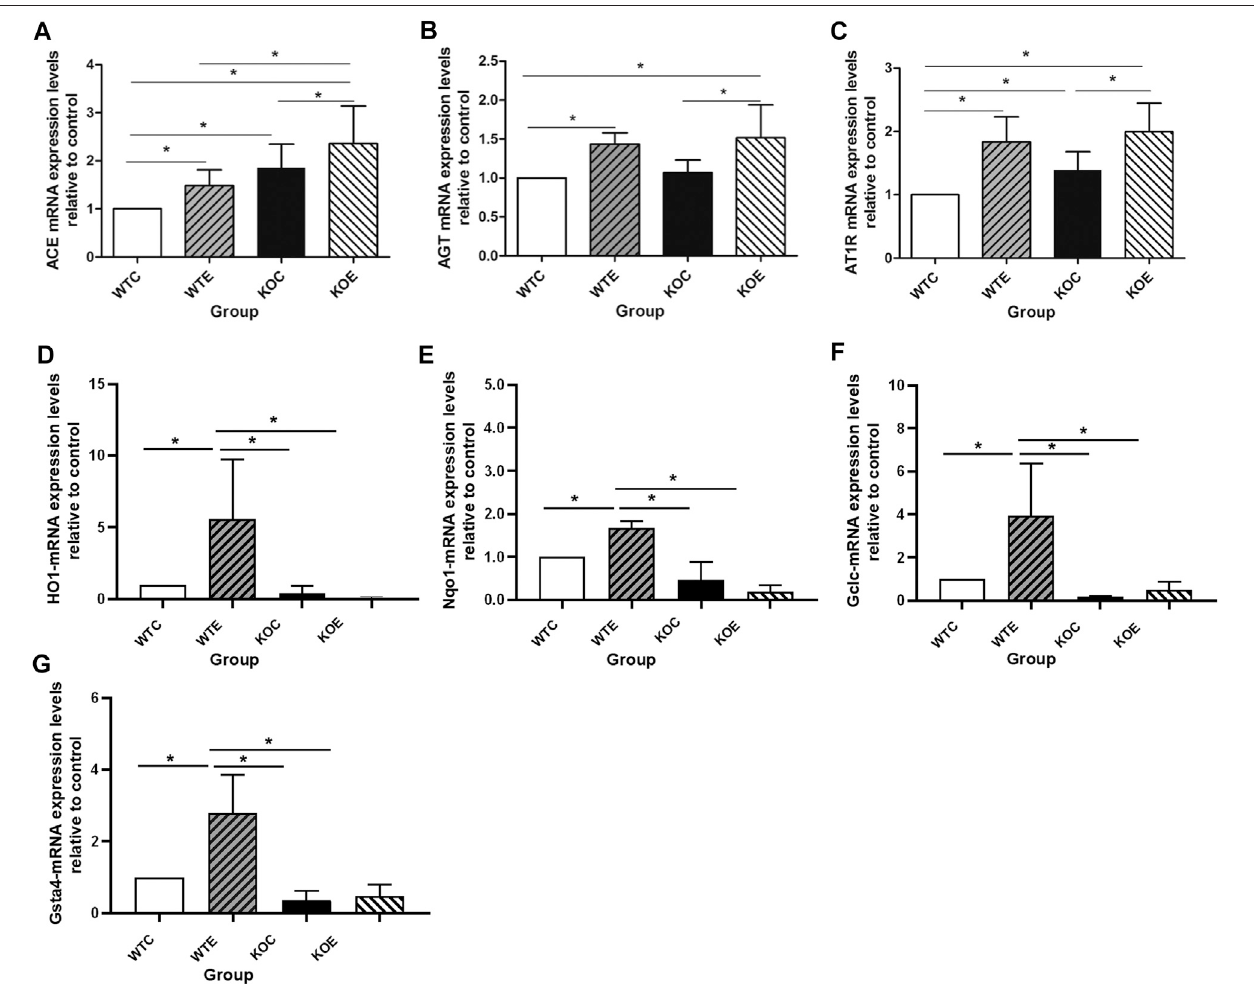
FIGURE2| QRT-PCRResults6 – 8weeksC57/B6mice,withorwithoutNrf2knockoutwereexposedtoeither fi lteredairoraircontainingparticulatematter(PM)for sixweeks,and thenthe vasculartissueswerecollected, snap-frozen inliquid nitrogen. N (cid:2) 3per group. WTC wasC57wild-typecontrolgroup, WTEwasC57wild-type PM exposure group, KOC was Nrf2-/- group control group, and KOE was Nrf2-/- group PM exposure group. *: statistically different between the two groups ( p < 0.05). (A) : Expression of ACE mRNA. (B) : Expression of AGT mRNA. (C) : Expression of AT1R mRNA. (D) : Expression of HO-1 mRNA. (E) : Expression of Nqo-1 mRNA. (F) : Expression of Gclc mRNA. (G) : Expression of Gsta-4